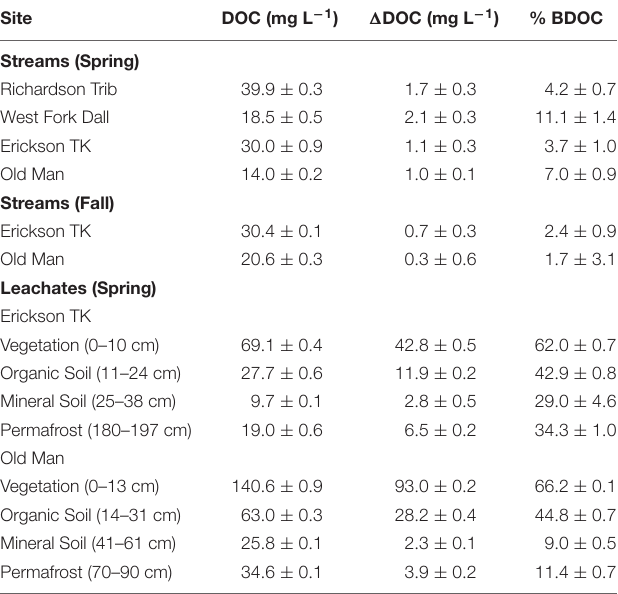
TABLE 2 | DOC concentration, (cid:49) DOC over 28 days, and percent of biodegradable dissolved organic carbon (BDOC), all reflecting the average and standard deviation of triplicate